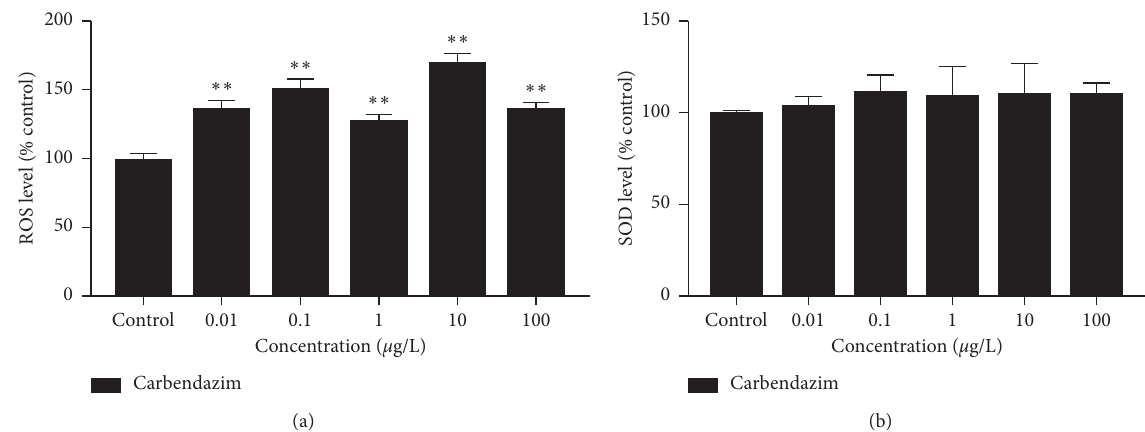
Figure 4: Effects of C. elegans on antioxidative system exposed to carbendazim. (a) The ROS level of C. elegans after carbendazim exposure; (b) the SOD level of C. elegans after carbendazim exposure. Data (mean ± SEM) are shown as the percentage value compared with the control group. The asterisks present significance between the each exposure group and control group ( ∗ p < 0 . 05 and ∗∗ p < 0 .